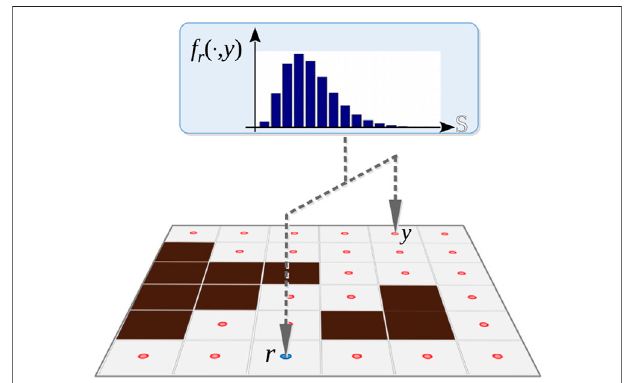
FIGURE 3 | For fi xed r , y , the plot shows the probability distribution over the signal space S .